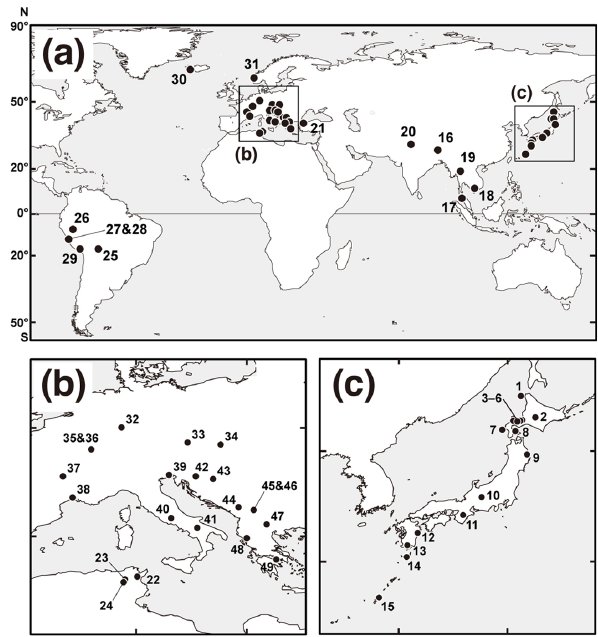
Fig. 1. Maps showing the distribution of the source wells worldwide (a) , and regionally (b) and (c)